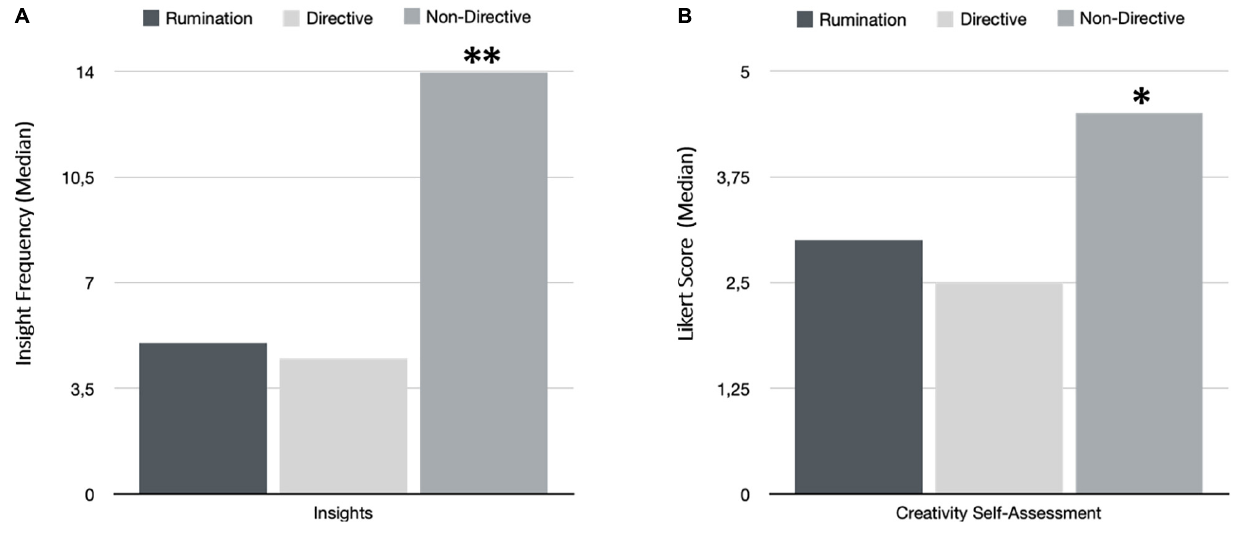
Frontiers in Education |